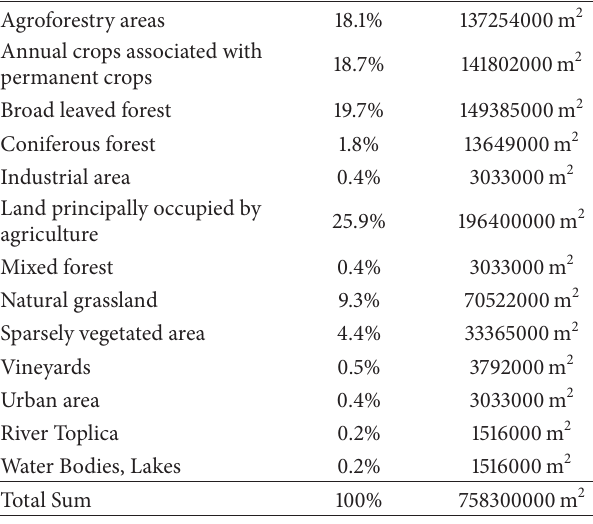
Table 5: The percentage and area of types of land on territory of Prokuplje Municipality in m 2 in 2012.